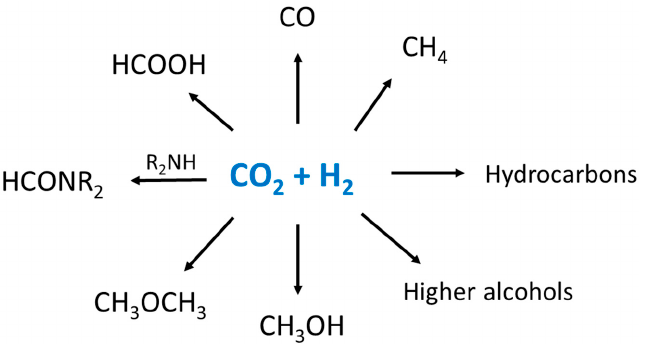
Figure 4. Catalytic CO 2 hydrogenation pathways to obtain fine chemicals and renewable fuels.